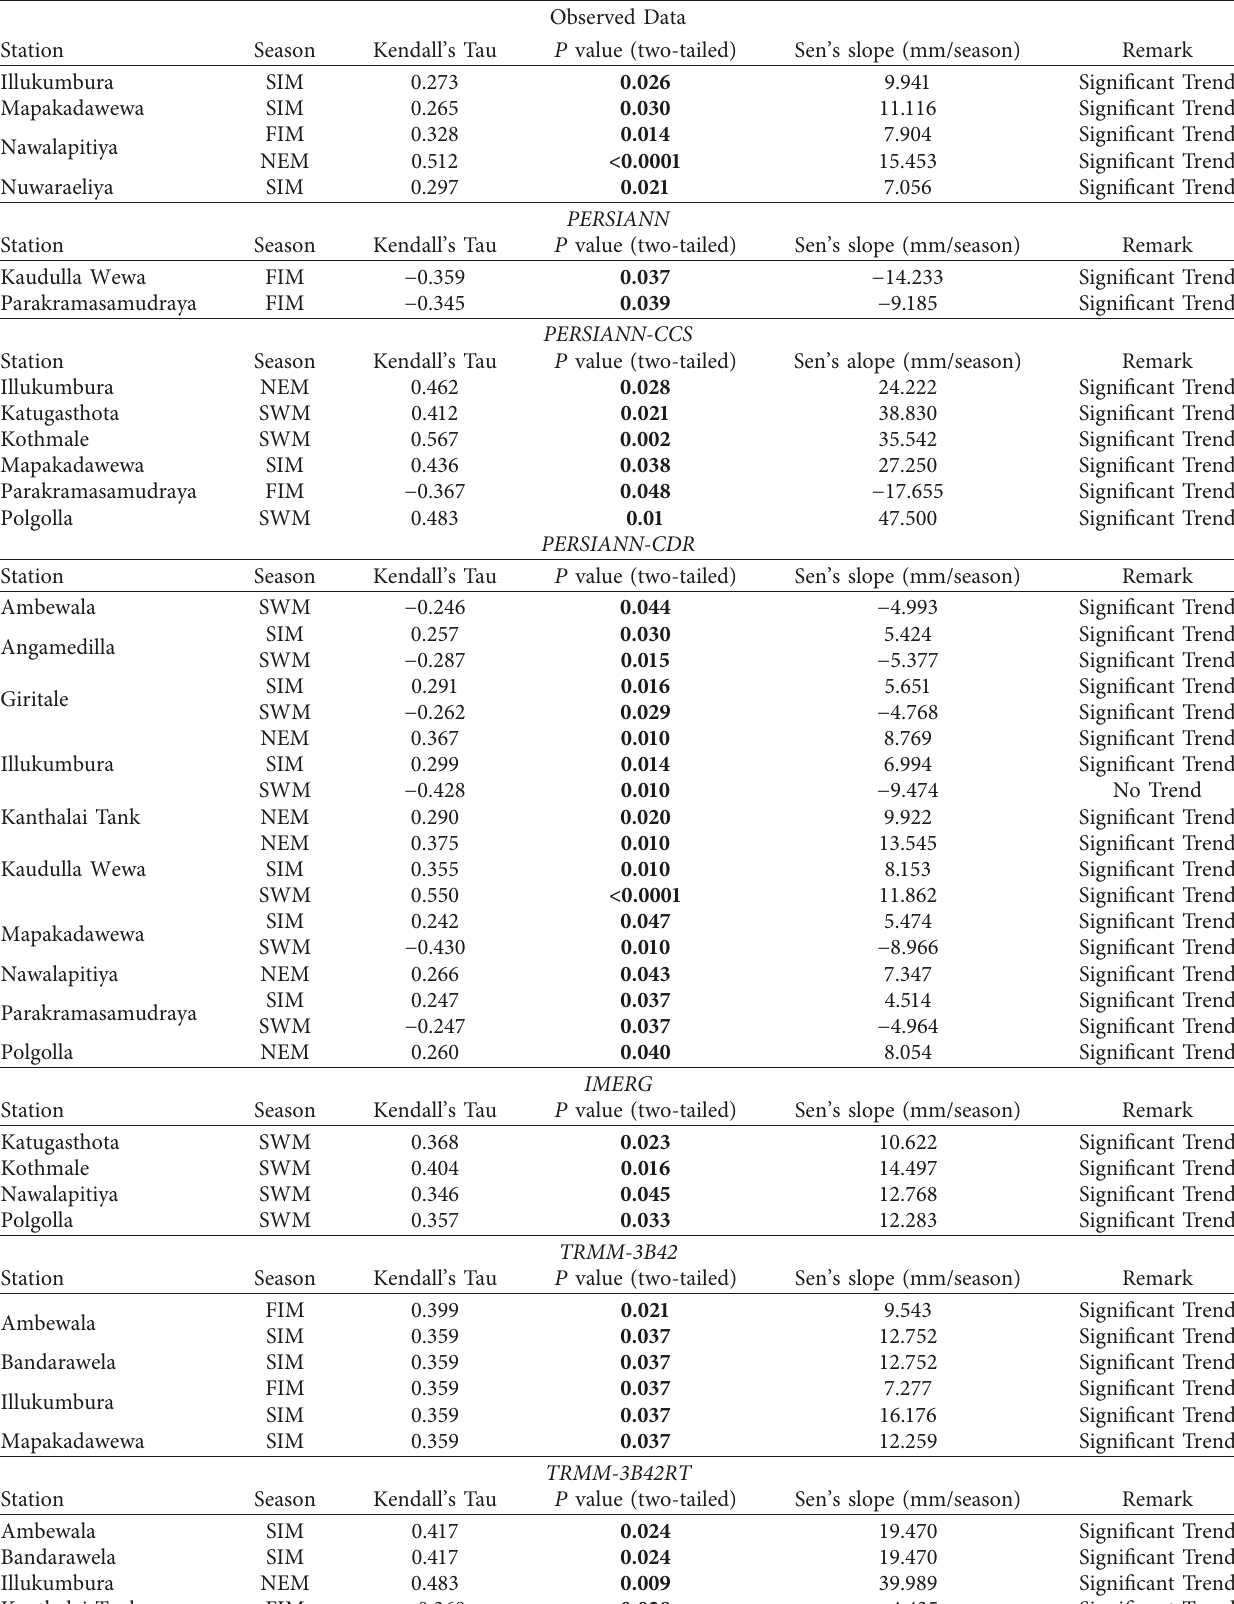
Table 7: Seasonal analysis of MK test and Sen’s slope estimator significant trend